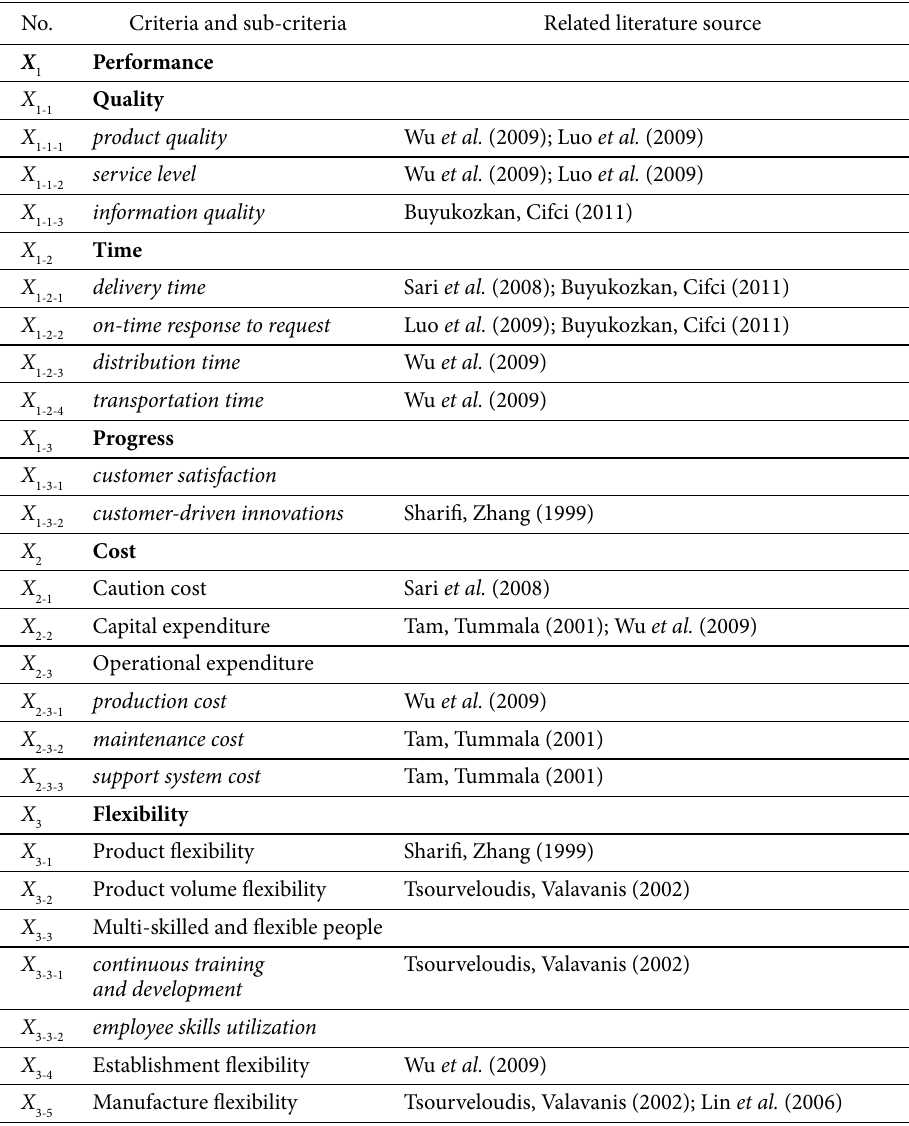
Table 1. factors taken from the review of the related literature and relevant to supplier evaluation and selection in an agile supply chain